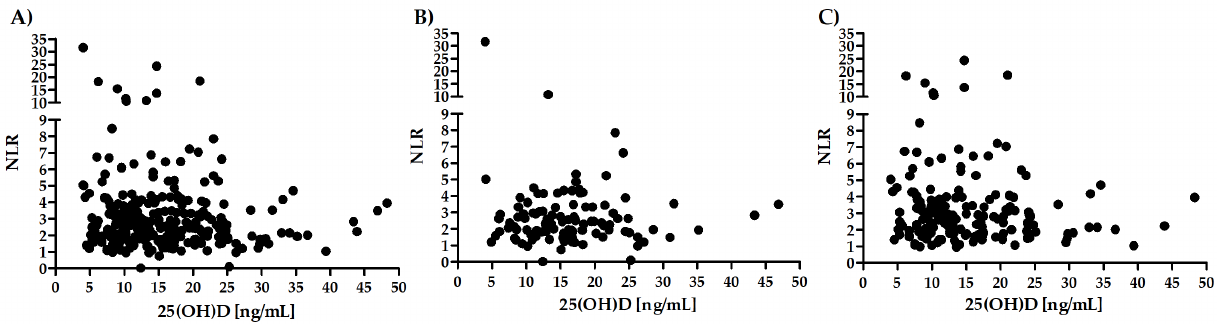
Figure 3. Correlation between the 25(OH)D level and NLR in the whole group ( A ) and subgroups of patients with stable CAD ( B ) and ACS ( C ).